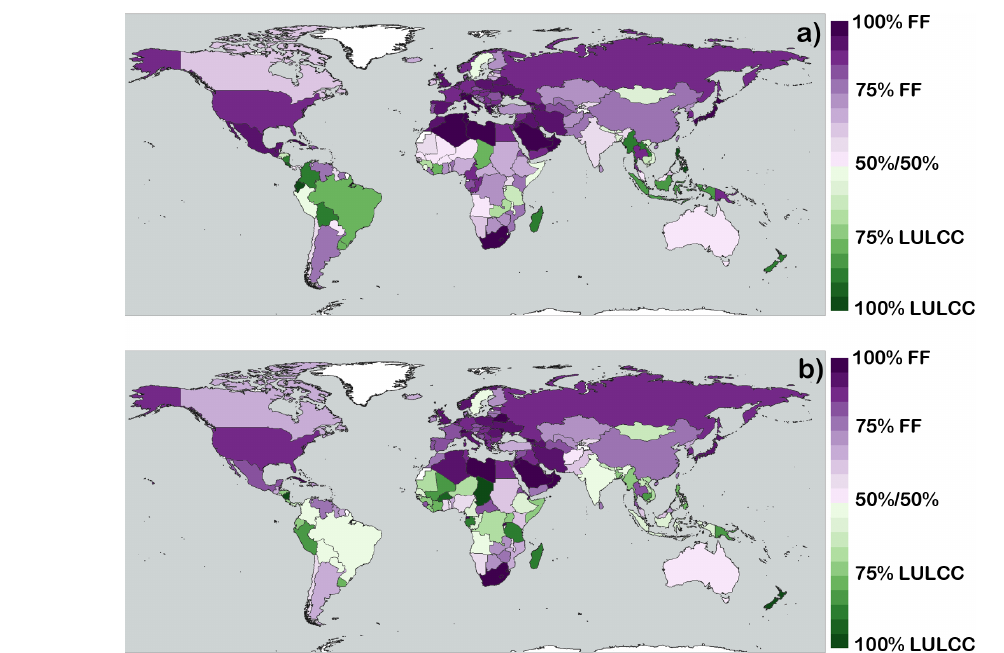
Figure 8. The ratio of the absolute value of LULCC RF to the absolute value of the RF of fossil fuel burning activities computed for each country for the year 2100 and the RCP4.5 scenario anthropogenic emissions and land cover change, including (a) all forcing agents, and (b) only greenhouse gas forcing